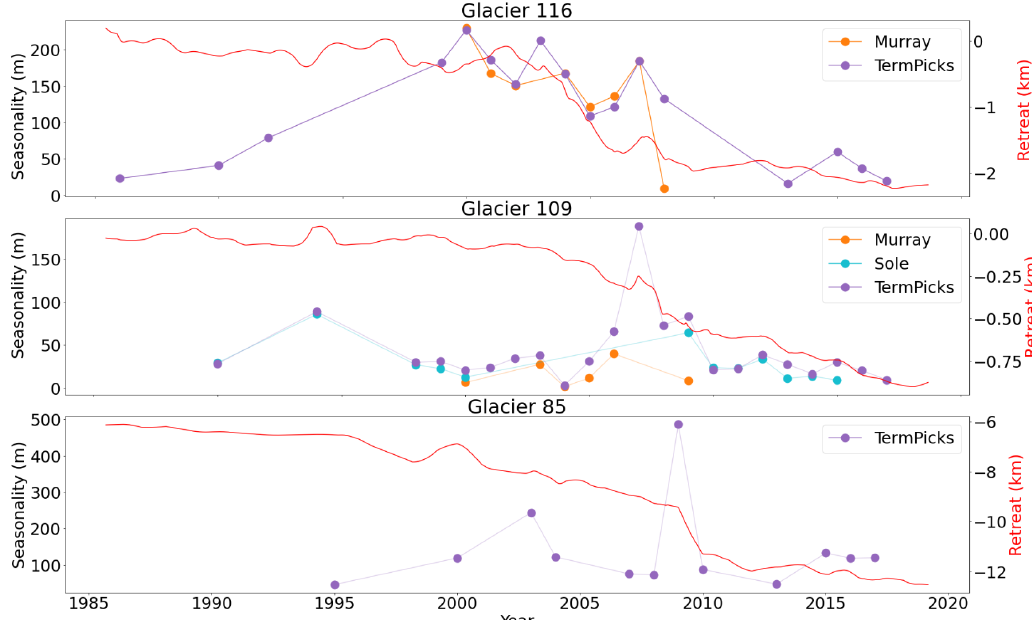
Figure 9. Example seasonality plots for three glaciers, F. Graae Gletscher (116), Heinkel Gletscher (109), and Humboldt Gletsjer (85). The location of each of these glaciers is noted in Fig. 8. Each color corresponds to either the entire TermPicks data set (purple) or an individual author. Glacier 85 has no individual author data set that can resolve the seasonality.